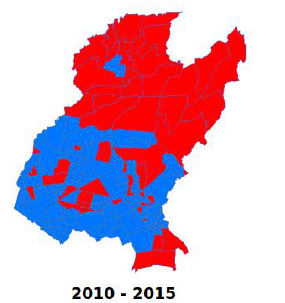
Figure 10. Geographic map of the clusters identified using SOM. Cluster 1 is red; Cluster 2 is blue.